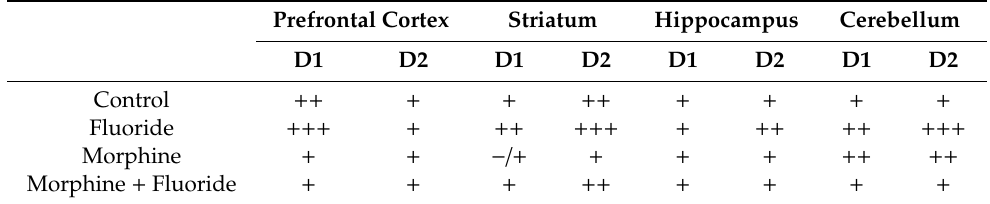
Table 1. Summary of the expression of dopamine receptors (D1 and D2) in the control and study groups presented as intensity of